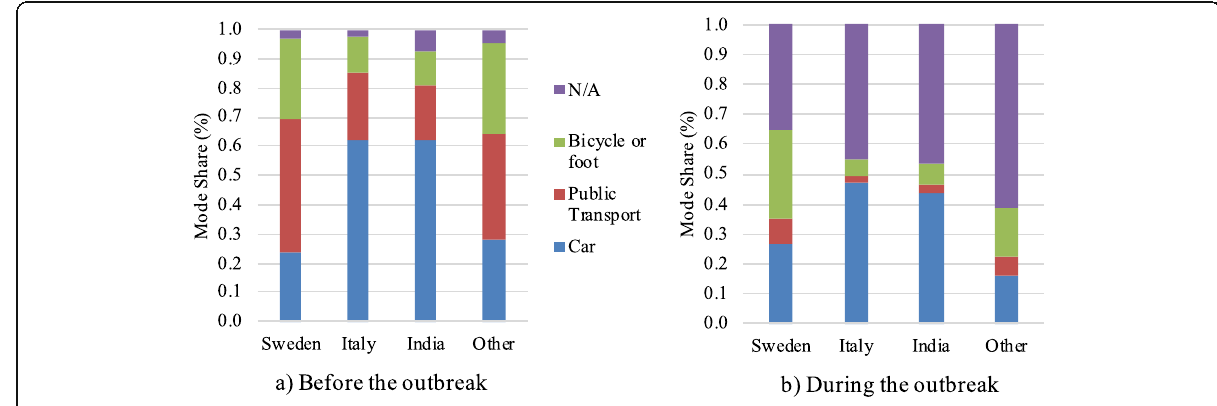
Fig. 3 Mode share divided by country of residence for the commuting modes to work or